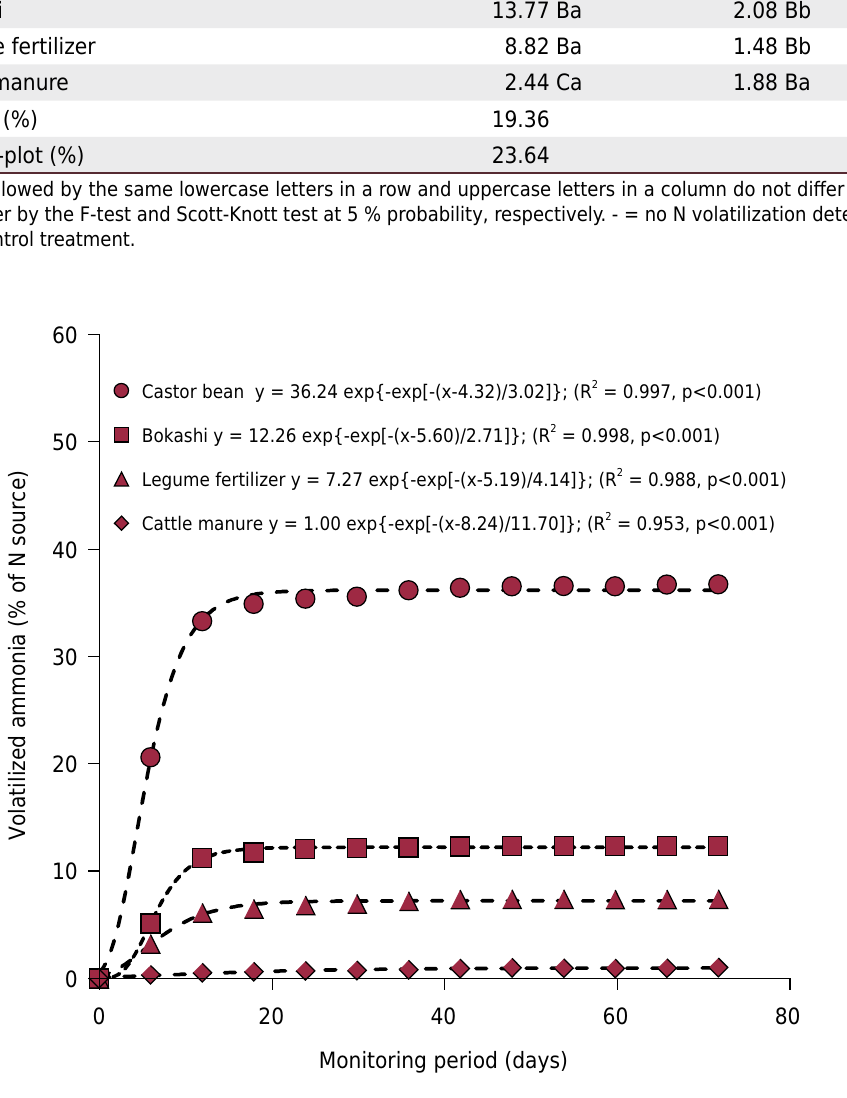
Figure 2. Ammonia volatilized from different surface-applied fertilizer sources (castor bean, bokashi, legume fertilizer, and cattle manure) in corn cultivation, within 72